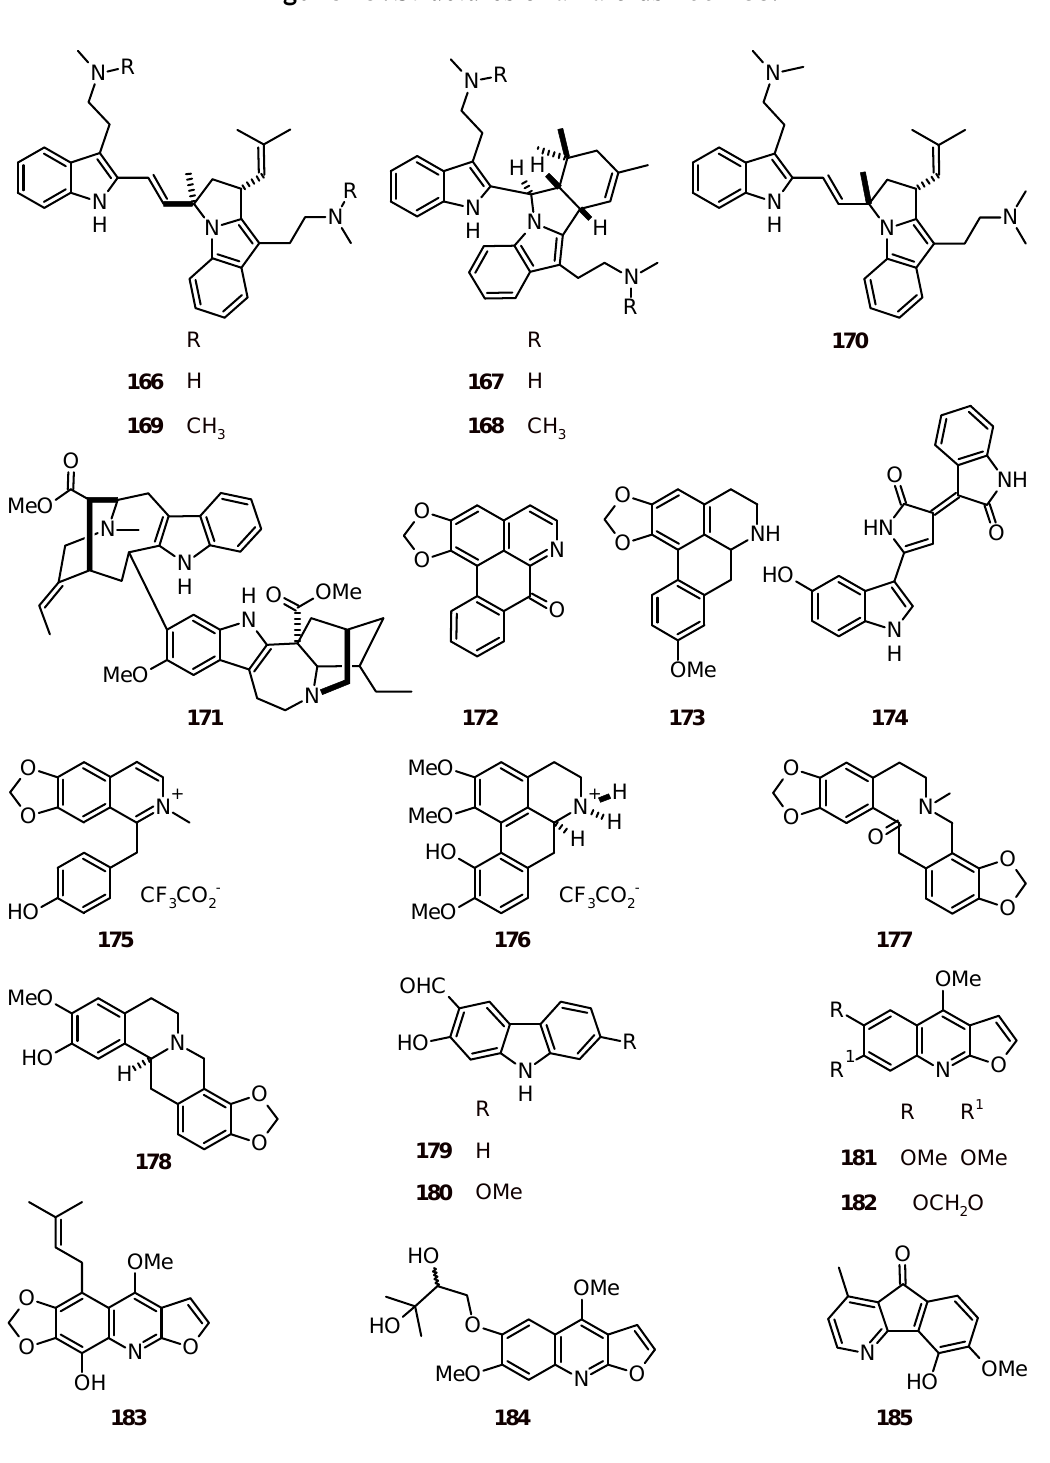
Figure 19. Structures of alkaloids 166 - 185